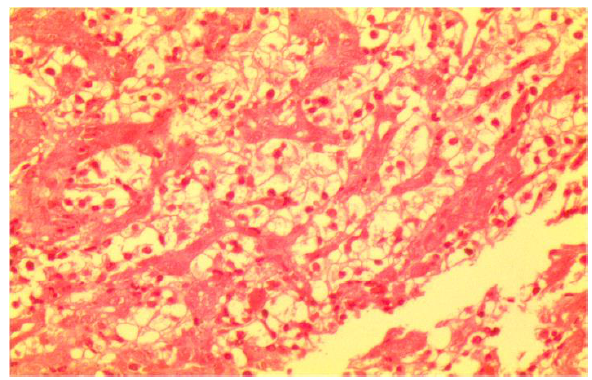
Fig 2. Aggregation of Large Cells With Abundant Cytoplasm